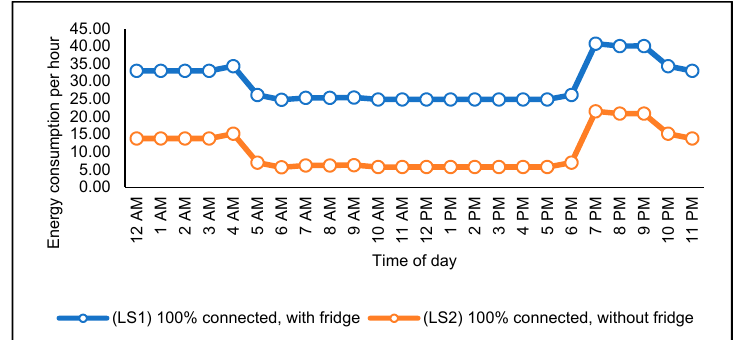
Figure 5. Projected daily electricity load demand for Pangan-an Island. Table 2. Electricity load scenarios (Pangan-an). Load Scenario Hours of Access Households Connected With or Without Fridge